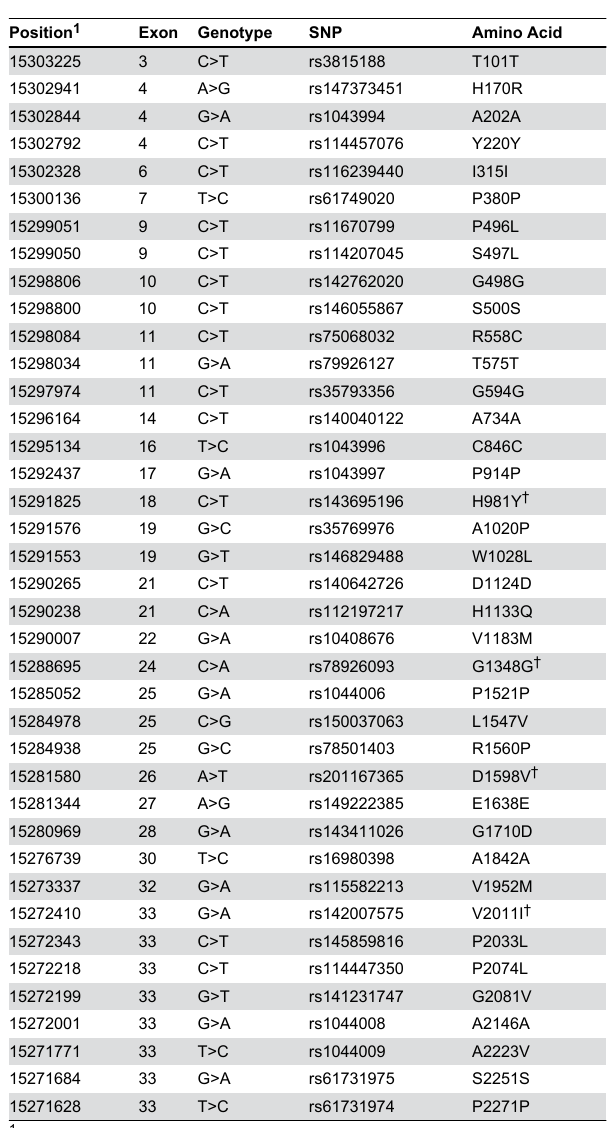
genome assembly. SNP=single nucleotide polymorphism. † Only observed in sequencing of 95 control subjects and not in subsequent screenings. na=not